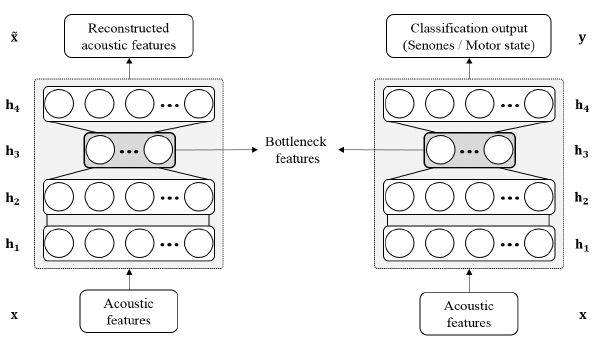
Figure 2. Extracting latent features using unsupervised ( left ) and supervised ( right ) methods.